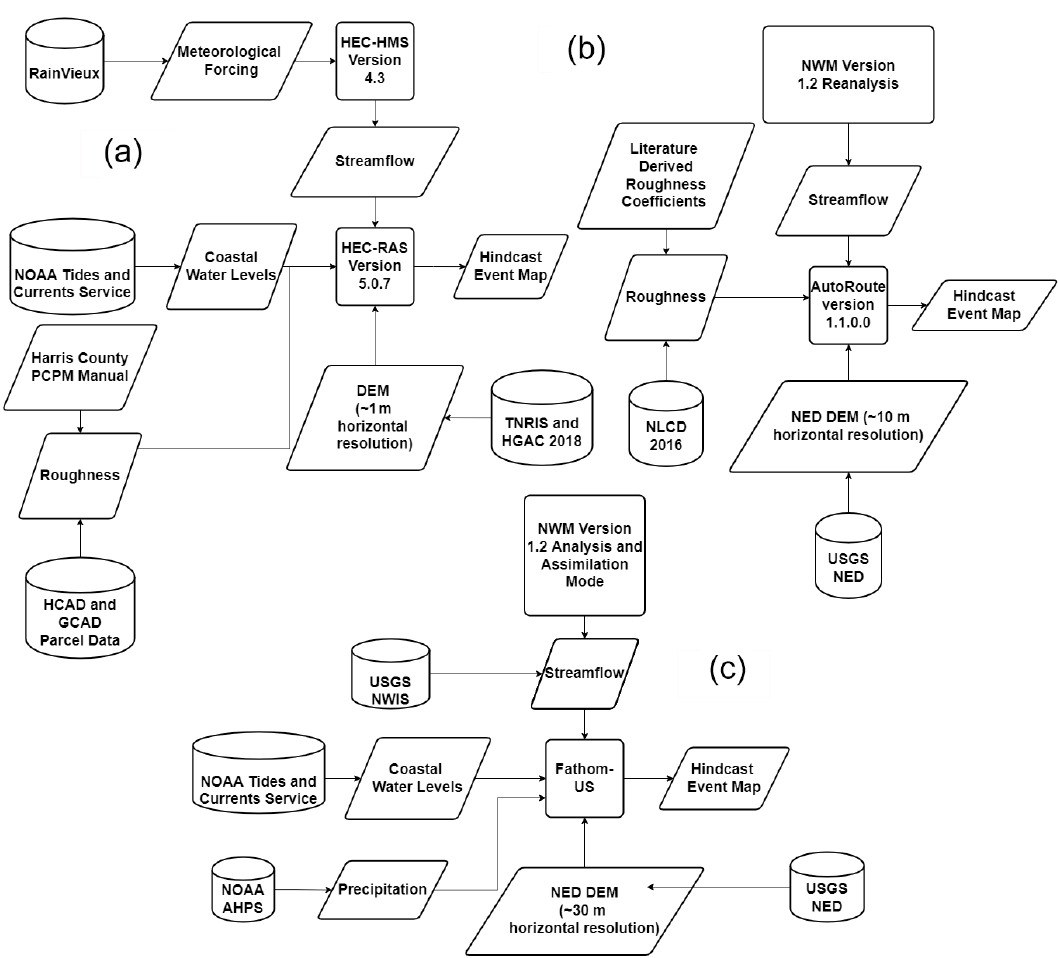
Figure 2. System flowchart for each of the FIM modeling frameworks that we compare in this study: (a) HEC-RAS modeling framework, (b) AutoRoute modeling framework, and (c) Fathom-US modeling